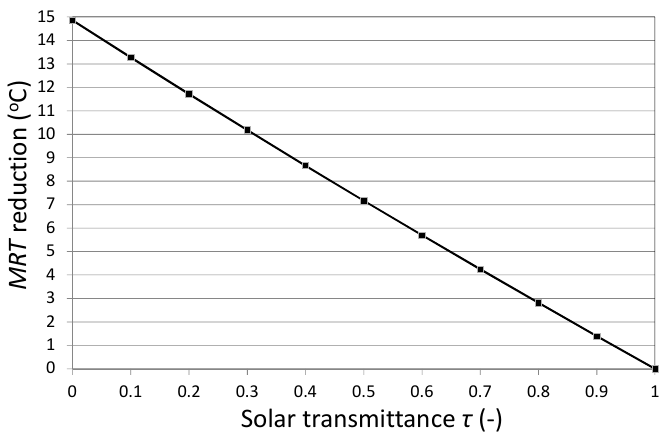
Figure 7. Relationship between solar transmittance τ and MRT reduction by adaptation measures.